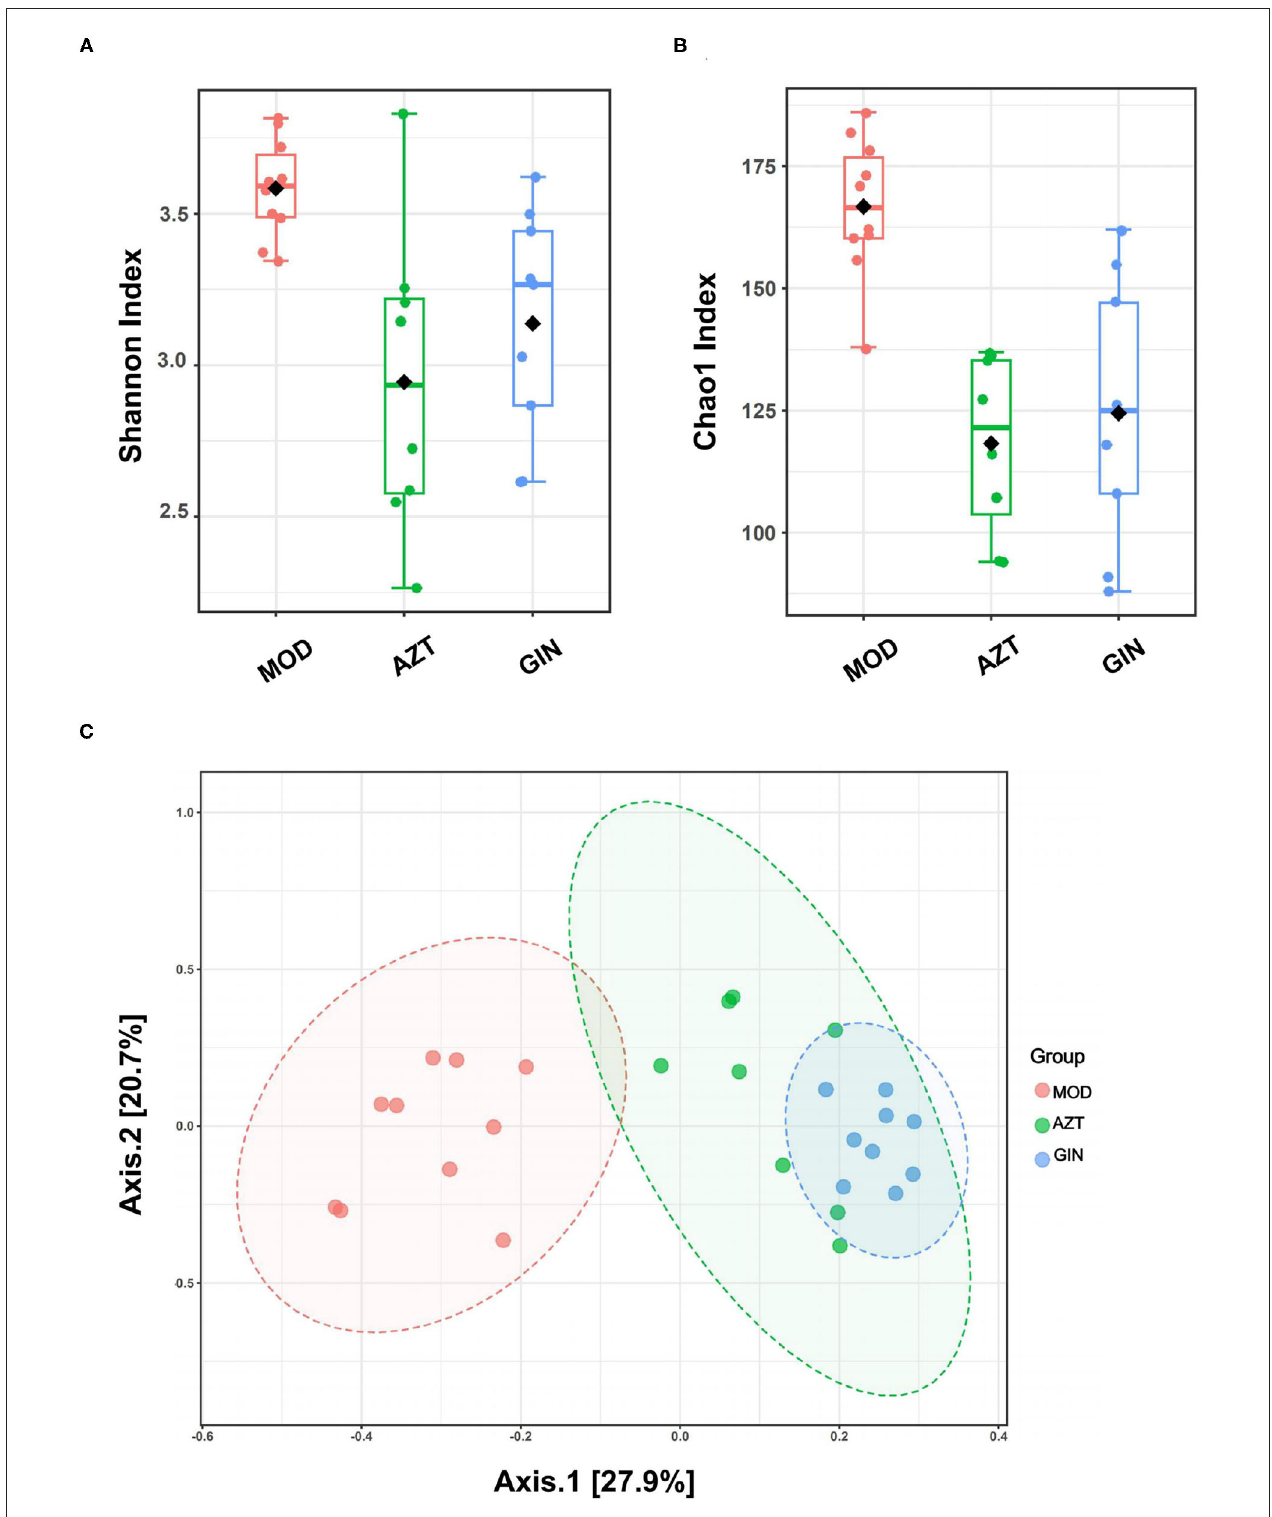
FIGURE 5 | Ginger modulates the diversity and structure of gut microbiota induced by early AZT exposure. Comparison of alpha diversity based on (A) Shannon index and (B) Chao1 index. (C) Multisample PCoA ( n = 8–10).